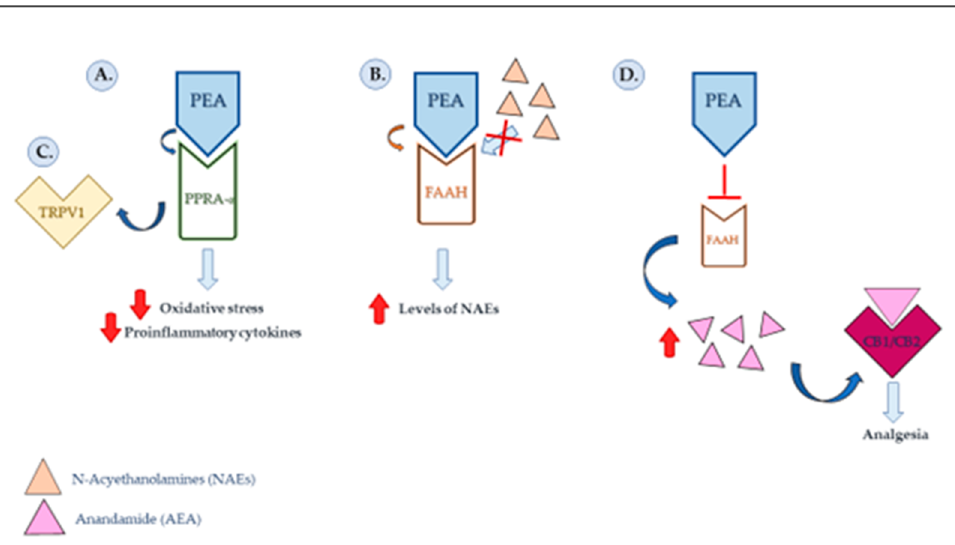
Figure 1. PEA’s mechanisms of action proposed for anti-inflammation and analgesia. ( A ) PEA is an agonist of the nuclear receptor PPAR- α , and its binding to it results in the repression of proinflammatory transcription factors, inducing a reduction in the release of inflammatory cytokines. ( B ) At high concentrations, PEA binds to the hydrolytic enzyme FAAH, competing with endogenous NAEs and reducing their degradation so as to promote the anti-inflammatory effect. ( C ) Through activation of PPAR- α , PEA can modulate the activity of a receptor channel (TRPV1), the dysfunction of which appears to be associated with several diseases, including neuropathic pain and inflammation. ( D ) PEA, by inhibiting FAAH expression, enables an increase in endogenous levels of the endocannabinoid, anandamide (AEA), presumably promoting analgesic action.